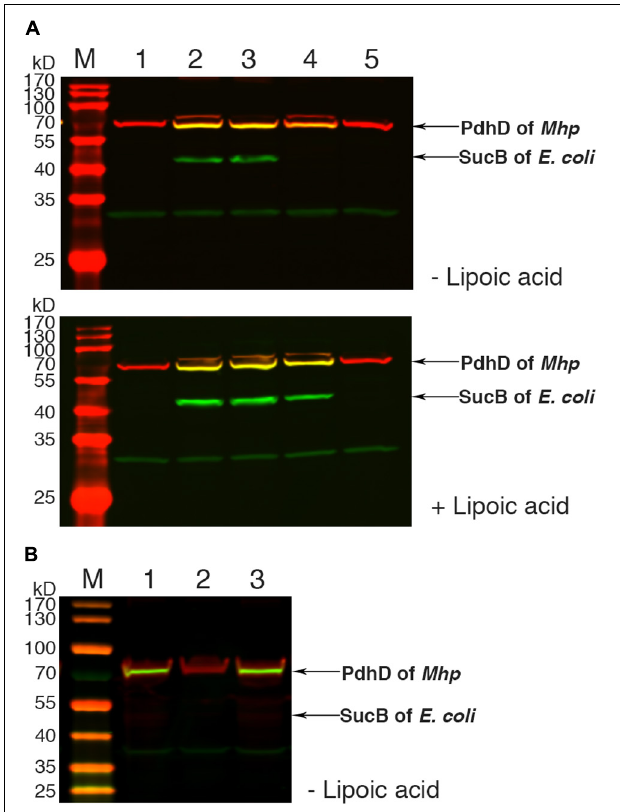
FIGURE 6 | Functional analysis of Mhp-LplJ in vivo . (A) Western blot analyses of protein lipoylation in RE0403 (MG1655 (cid:49) aceF:pdhD (cid:49) lplA (cid:49) lipB ) complemented strains. Lanes 1–5, strain RE0403 expressing no enzyme, E. coli LplA, E. coli LipB, Mhp-LplJ, and Mhp-Lpl respectively. (B) Western blot analyses of protein lipoylation in RE0403-derived strains. Lane 1, RE0403 (MG1655 (cid:49) aceF:pdhD (cid:49) lplA (cid:49) lipB ) expressing Mhp-LplJ; lane 2, RE1011 (MG1655 (cid:49) aceF:pdhD (cid:49) lplA (cid:49) lipB (cid:49) lipA ) expressing Mhp-LplJ; lane 3, RE1009 (MG1655 (cid:49) aceF:pdhD (cid:49) lplA (cid:49) lipB (cid:49) gcvH ) expressing Mhp-LplJ. The total protein of bacteria was analyzed with western blot assays after culturing for 36 h in Luria broth supplemented (+) or not (–) with lipoic acid using both Anti-LA (green) and Anti-PdhD